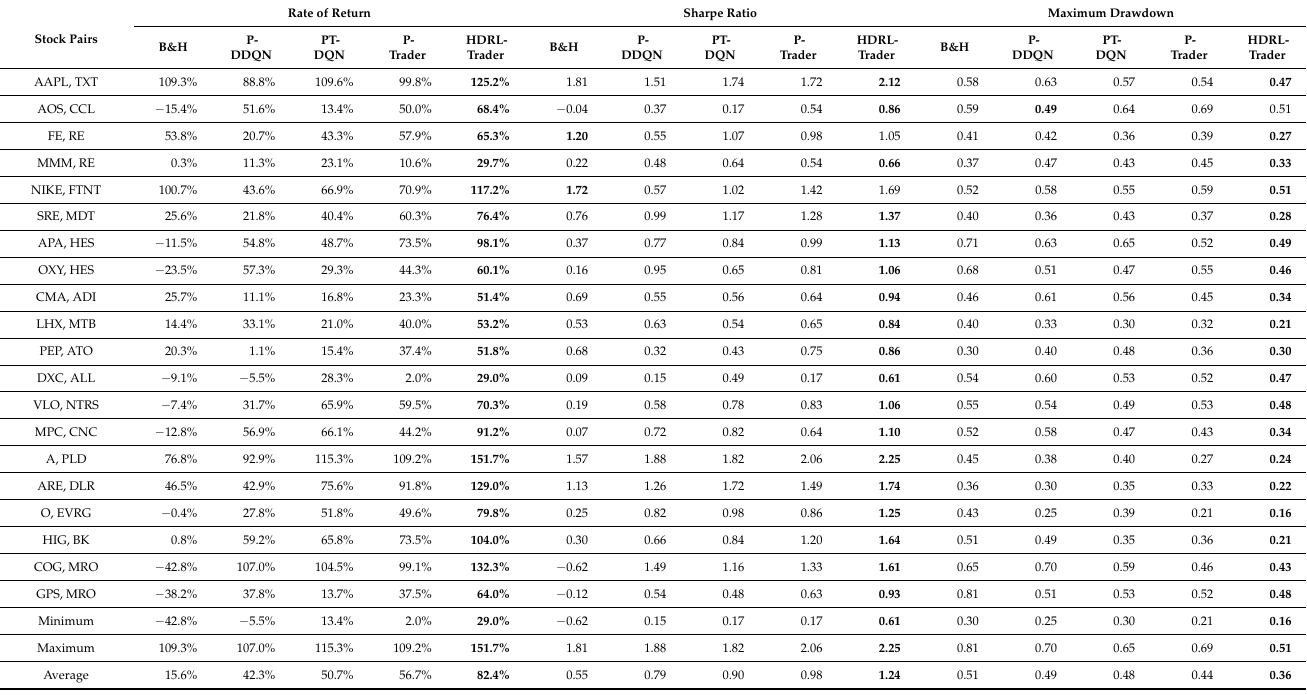
Table A1. Experimental results on the larger